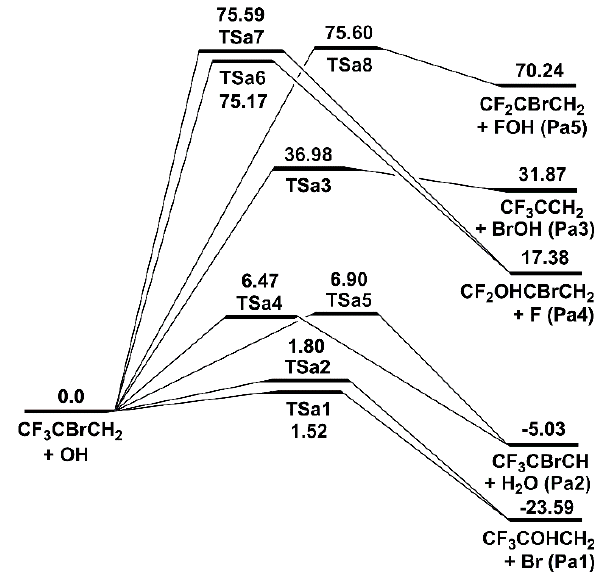
Figure 3. Schematic energy diagram of abstraction and substitution channels for the 2-BTP + OH reaction at 0 K in kcal/mol at CCSD(T)/aug-cc-pVTZ//B3LYP/aug-cc-pVTZ (zero-point vibrational energy included).